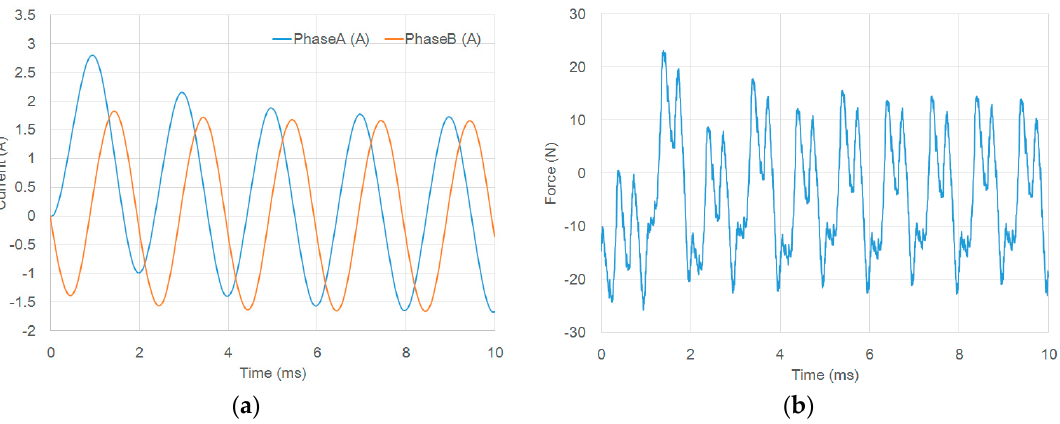
Figure 17. The machine FEM simulations ( a ) phase current outputs and ( b ) electromagnetic force.